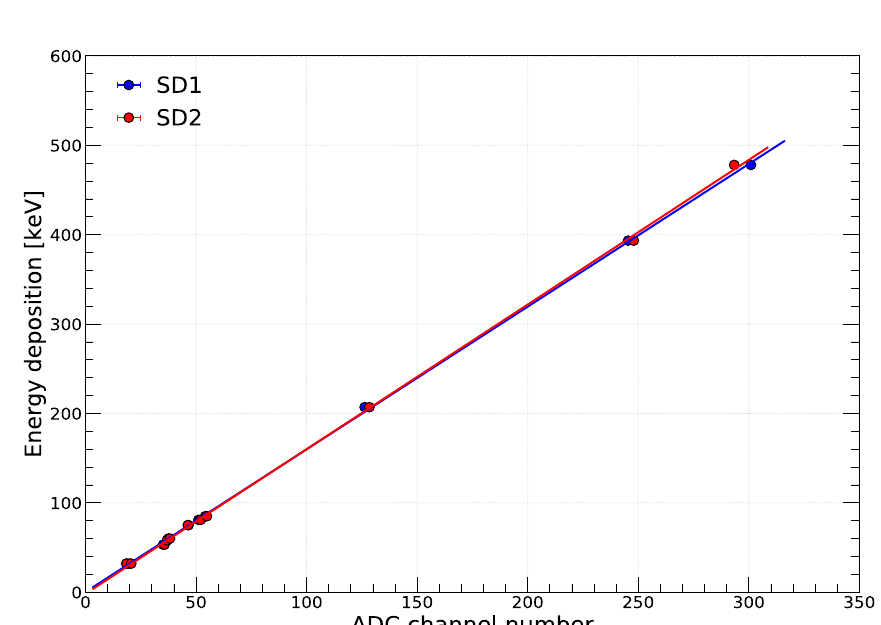
Figure A.4. The resulting energy calibration curves for the high-gain channel of both SDs. Supplementary data are available on the website.